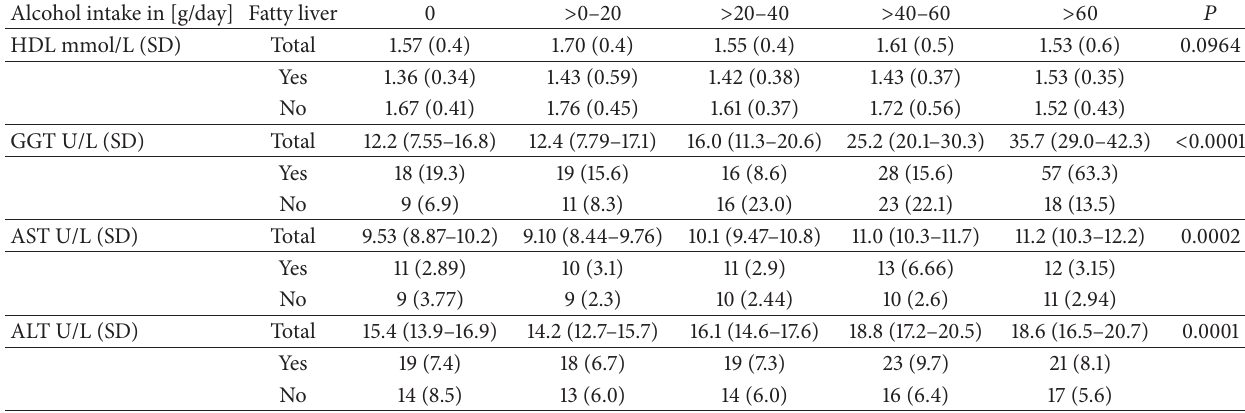
Table 2: Arithmetic mean with standard deviation of serum concentrations of ALT, GGT, and HDL, according to alcohol consumption ( 𝑃 for difference between categories).